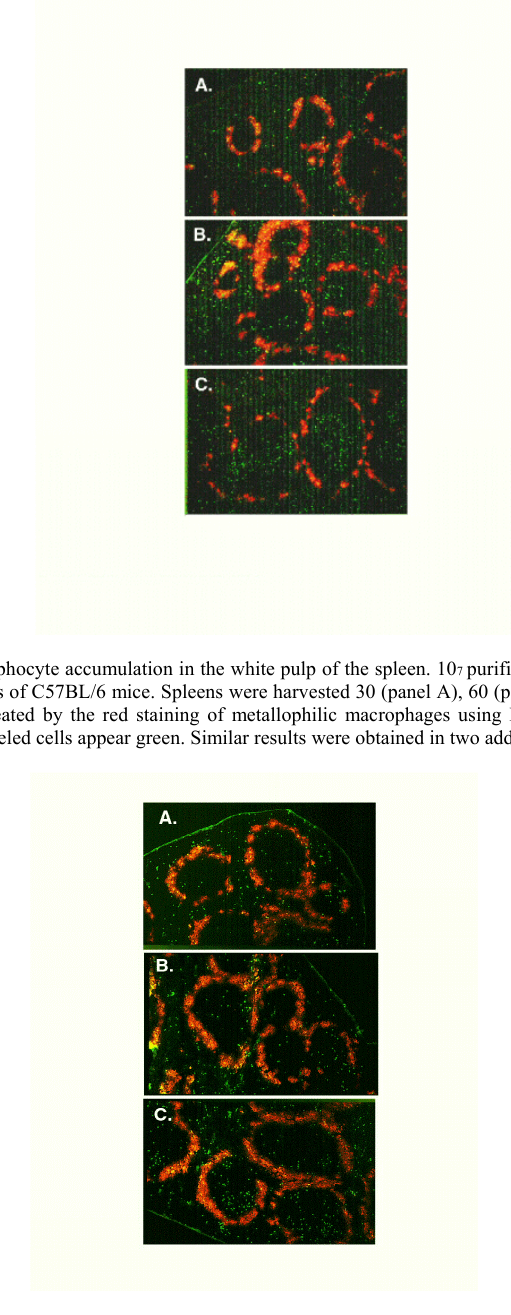
FIGURE 2. Time course of B lymphocyte accumulation in the white pulp of the spleen. 10 7 purified B cells were treated as in Fig. 1. Spleens of recipient mice were harvested at 2 (panel A), 3 (panel B), and 4 (panel C) h after transfer. Spleens were frozen, sectioned, and stained as in Fig. 1. These images are representative of three similar experiments.